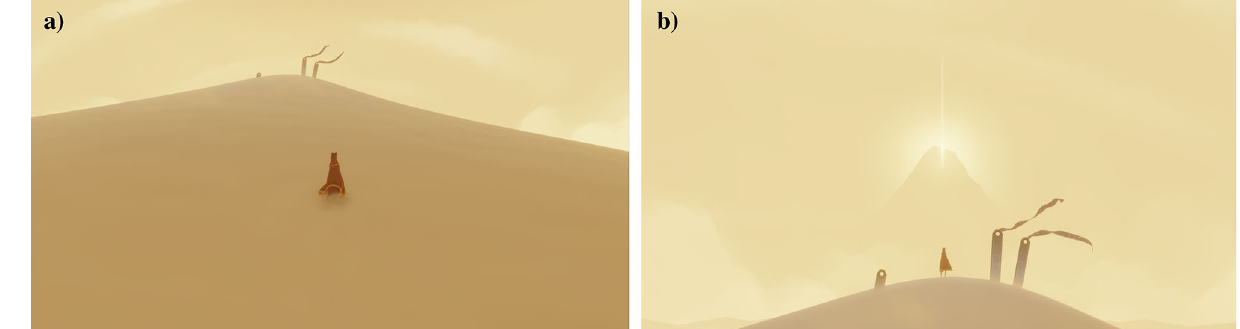
Figure 1. Images from the visual inducer video. A figure ascending a small hill was visible ( a ). Shortly after the figure reached the top of the small hill, a large mountain ( b ), barely visible, appeared in the far distance, and participants were instructed to close their eyes and imagine a continuation of the journey towards the